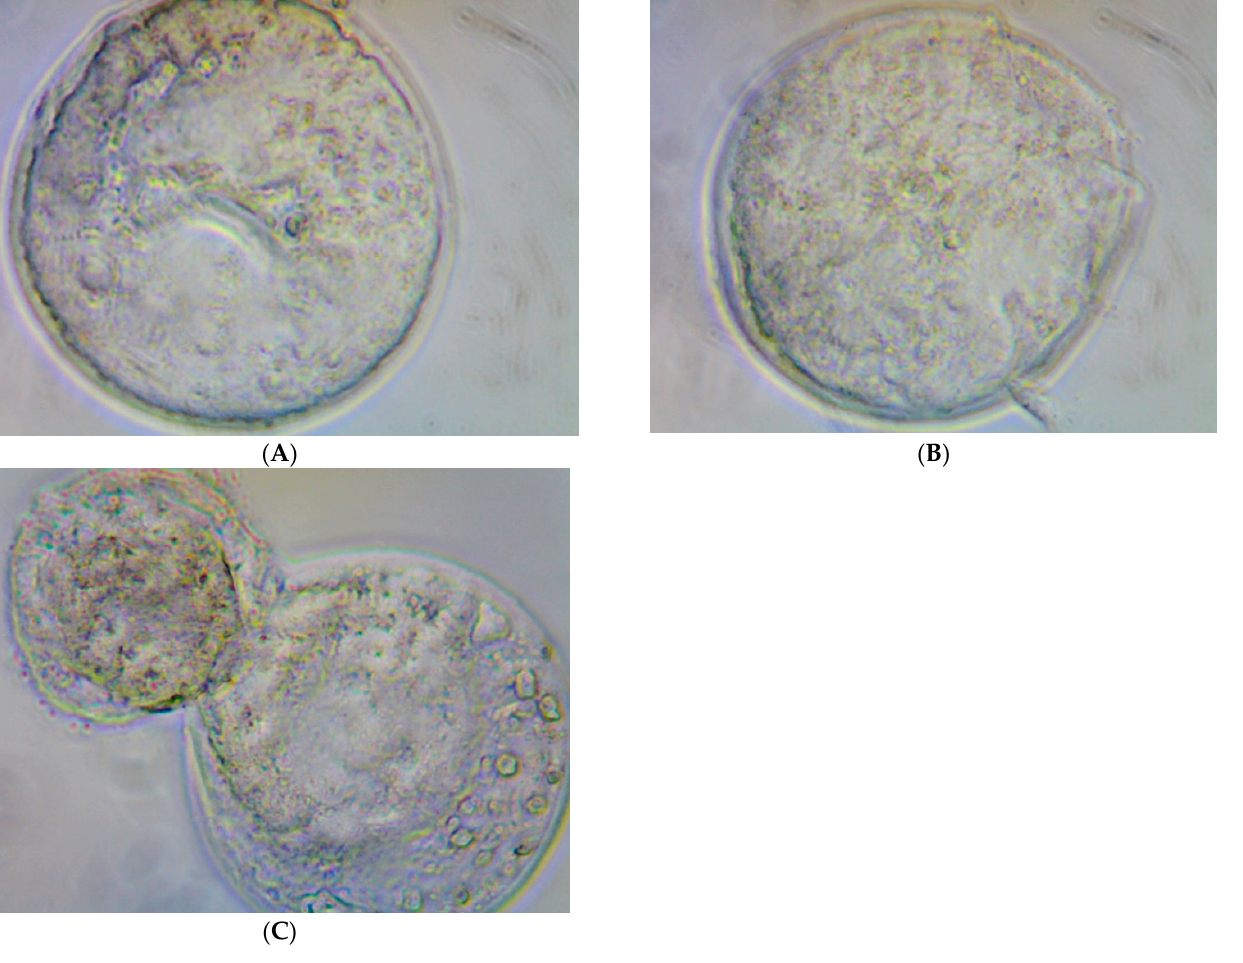
Figure 6. Illustrations from the contrast microscope at 200X magnification: ( A ) blastocysts; ( B ) ex- panded blastocyst; ( C ) hatched blastocysts; all DAB-stained in vitro bovine embryos (Experiment 2/IVP Replicate 3) used 40 µg/mL of rHGAL-1 supplementation (Group 4).